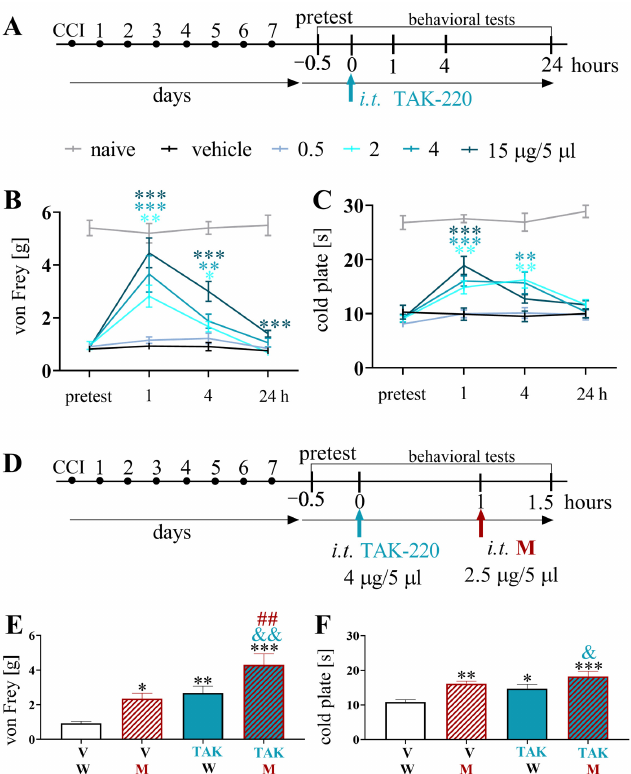
Figure 7 Figure 7. The effects of CCR5 antagonists (TAK-220) administered intrathecally (i.t.) according to timeline ( A ), at doses of 0.5, 2, 4, and 15 µ g/5 µ L on mechanical ( B ) and thermal ( C ) hypersensitivity and the influence of TAK-220 at a dose of 4 µ g/5 µ L plus morphine 2.5 µ g/5 µ L on mechanical ( E ) and thermal ( F ) hypersensitivity, administered according to timeline ( D ), 7 days after CCI in mice. The data are presented as the mean ± SEM (naive n = 5; CCI n = 8–10). The results were evaluated using one-way ANOVA followed by Bonferroni’s post hoc test for comparisons of selected pairs. * p < 0.05, ** p < 0.01, and *** p < 0.001 indicate significant differences vs. V-treated